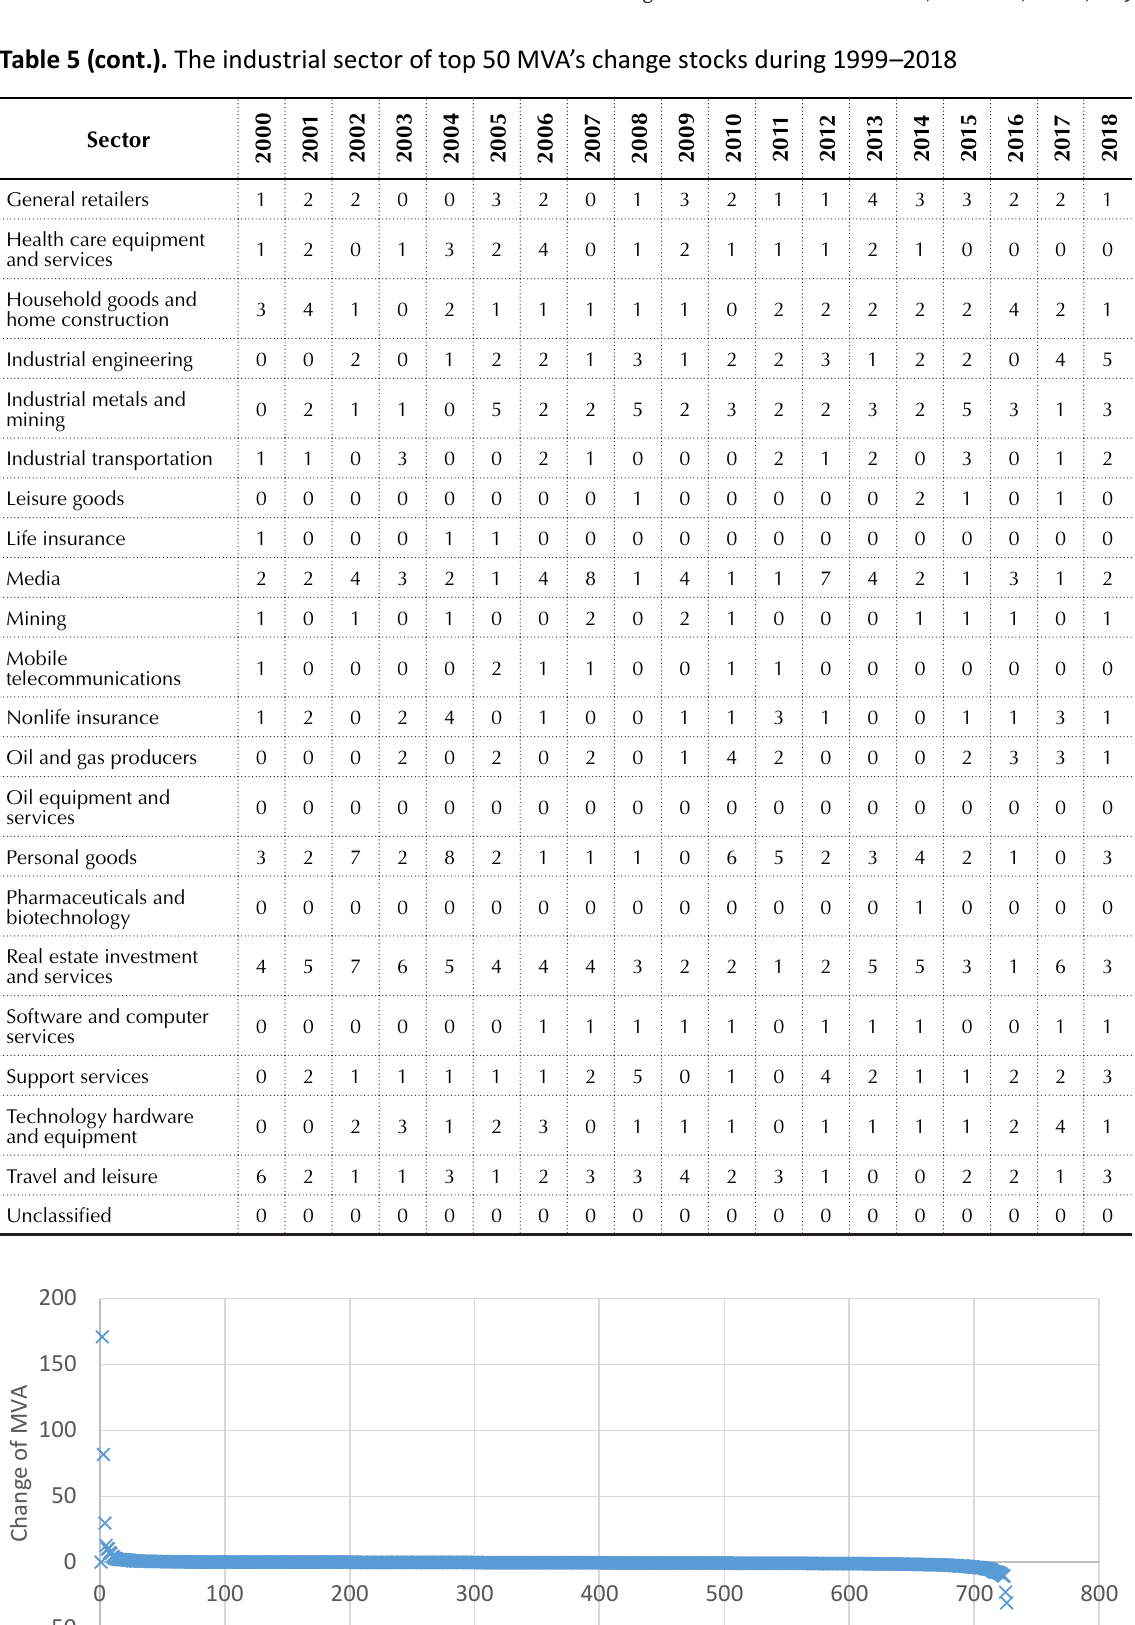
Figure 2. The scatter plot of 2018 MVA’s change and market value